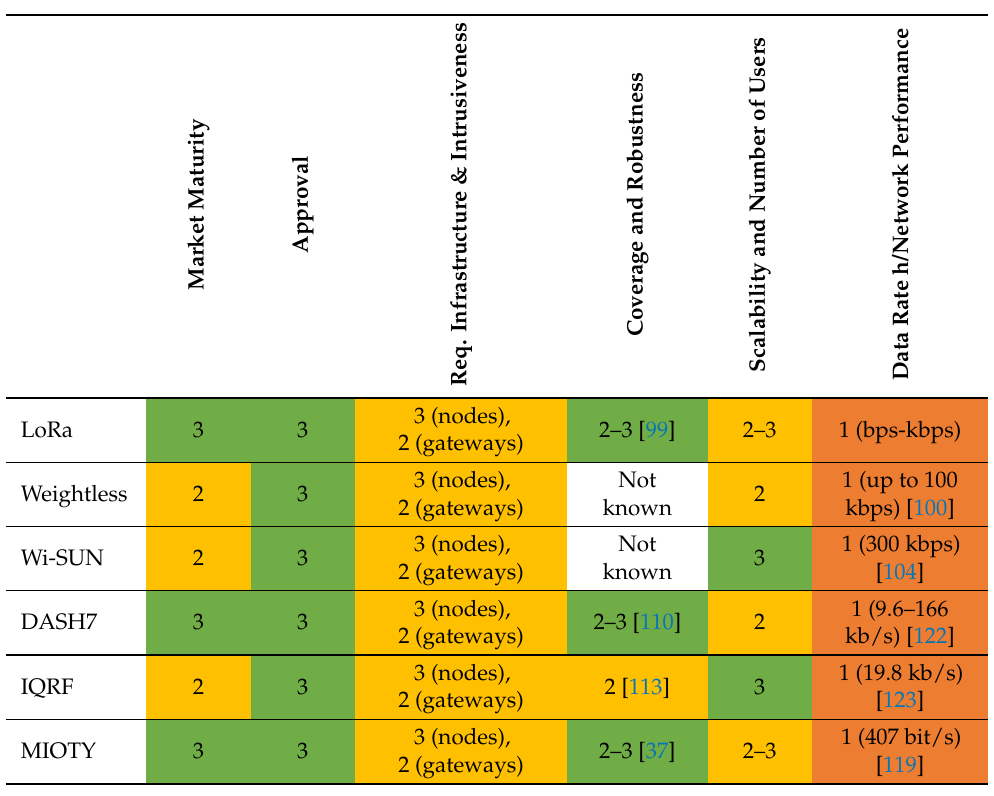
Table 3. Summarized Comparison and Evaluation of LoRa, Weightless, Wi-SUN, DASH7, IQRF and